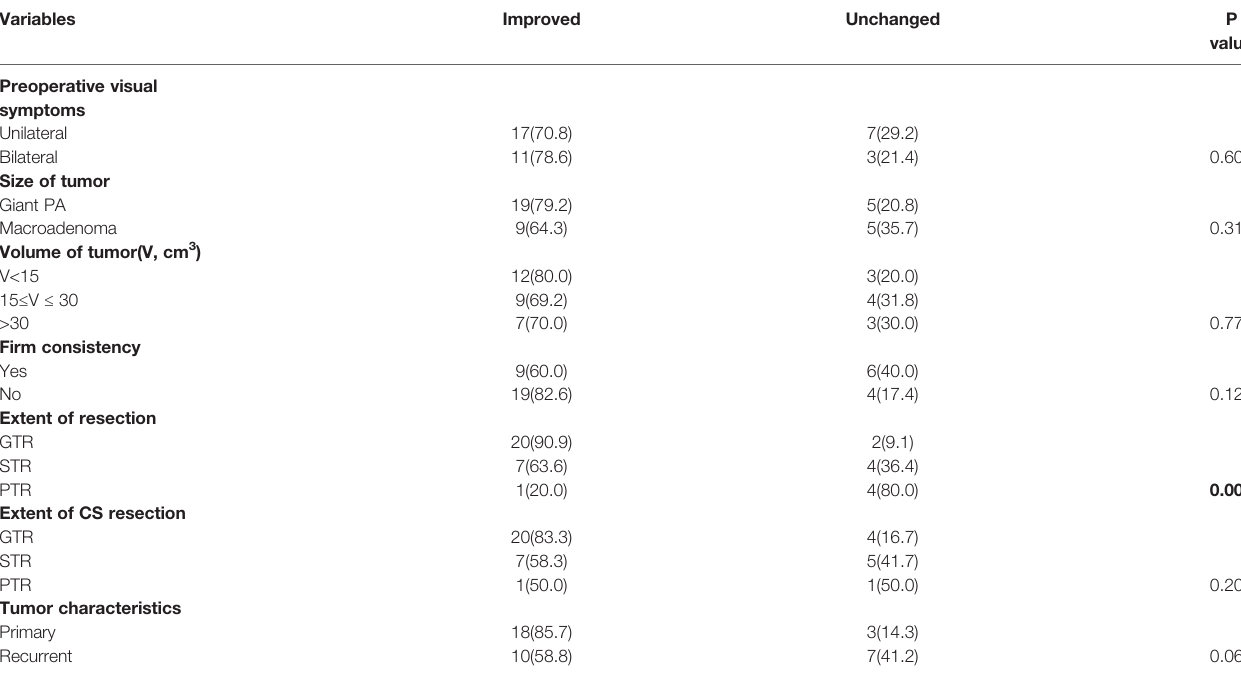
TABLE 7 | Visual outcomes correlated with multiple potential